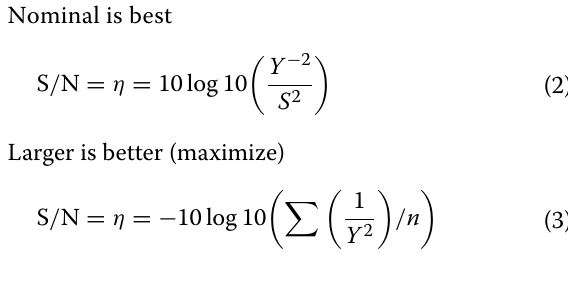
Table 3 Experimental results of surface roughness Ra Experimental Speed of serial number cut V (m/